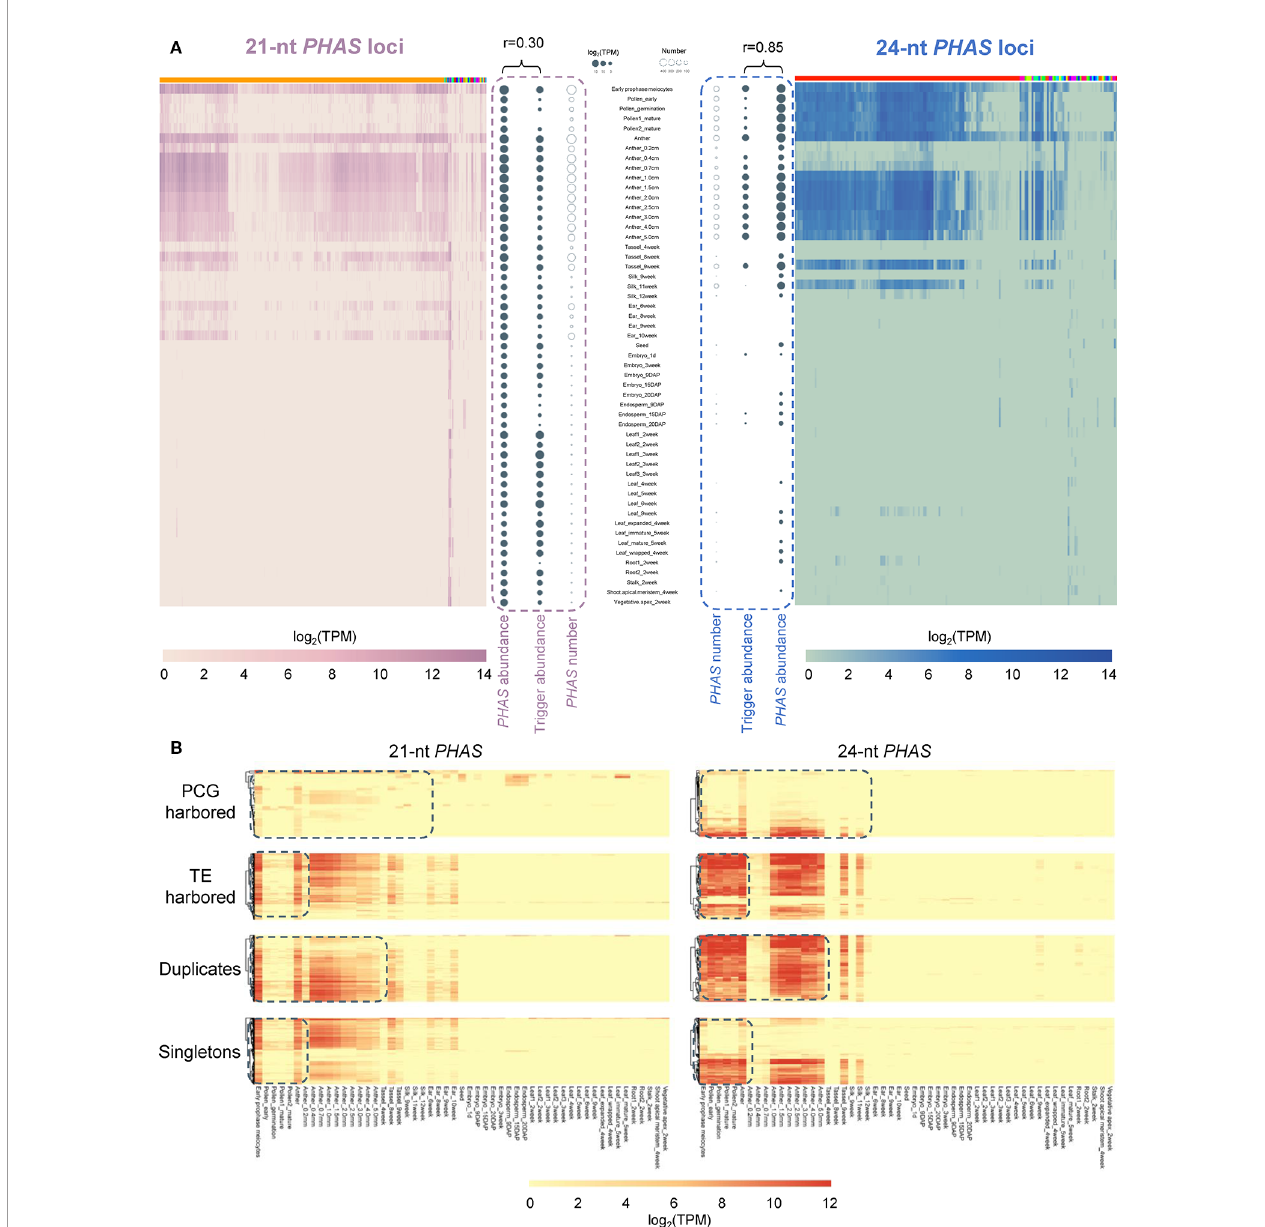
FIGURE 6 | Differentiation of 21- and 24-nt PHAS loci in relation to tissue speci fi city. (A) Heat maps depicted the abundance of 21-nt PHAS loci (left) and 24-nt PHAS loci (right) in individual tissue samples. Solid bubbles represent the total abundance of phasiRNAs and corresponding miRNA triggers. Circles represent the number of PHAS loci. In the heatmaps, PHAS loci were clustered according to the miRNA triggers. Color bars on the top of heatmaps represent different triggers, among which orange represents miR2118 and red represents miR2275. (B) Heat maps depicted the abundance of 21- and 24-nt PHAS loci in four categories (PCG harbored, TE harbored, duplicates, and singletons). The dashed boxes indicated the divergence between the abundance of 21- and 24-nt PHAS loci in corresponding tissue